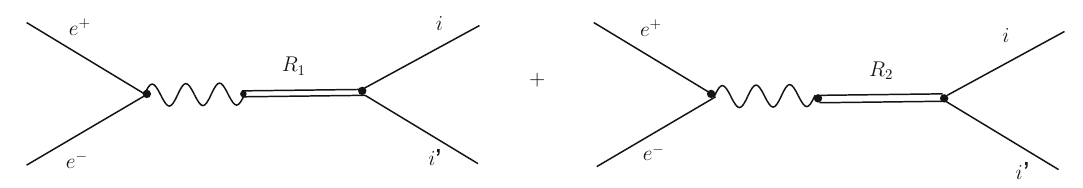
Fig. 1 Feynman diagrams of e + e − → R 1 ( R 2 ) → i i (cid:5) , where R 1 ≡ ψ( 4040 ) and R 2 ≡ ψ( 4160 ) and i , i (cid:5) correspond to any of the D 0 ¯ D 0 , D + ¯ D − ,